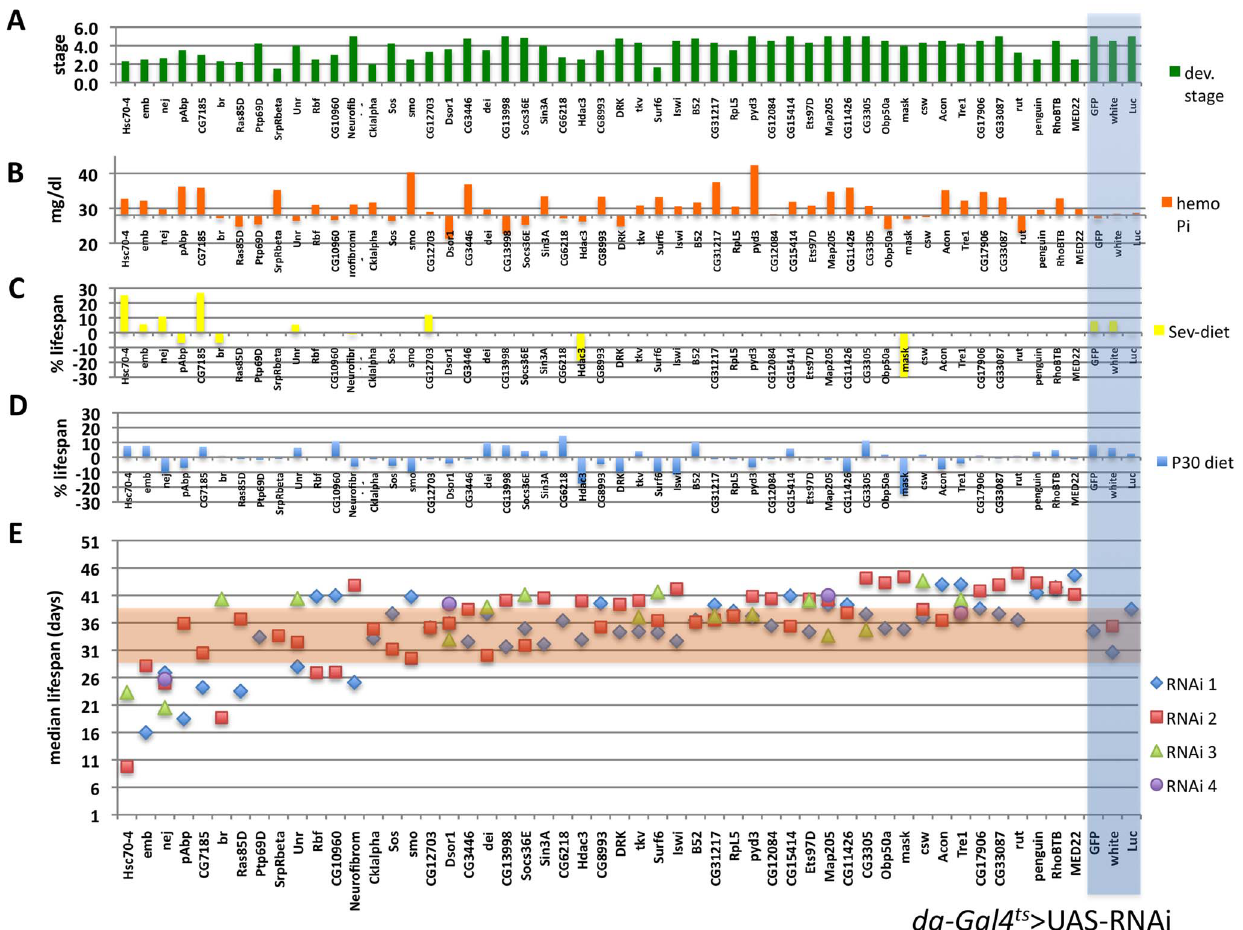
Figure 7. Invivo secondary screen using the da - Gal4 ts as driver identifies genetic modifiers of Drosophila larval development, and adult hemolymph phosphate and lifespan. A: Developmental stage on standard medium, B: hemolymph phosphate concentration of young adult females cultured at 29 u C for five days, and % change of life span on standard medium supplemented with 1% sevelamer ( C ), or 30 mM sodium phosphate ( D ) when compared to standard medium alone ( E ) (see also Table S1).